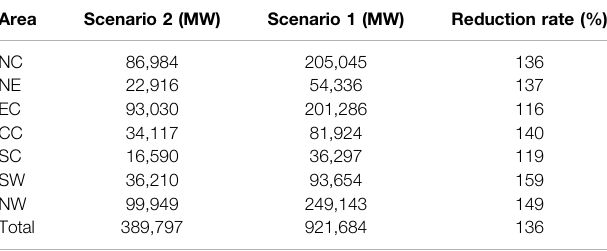
NC, NE, EC, CC, SC, SW, NW, respectively represents North China, Northeast China, East China, Central China, South China, Southwest China, Northwest China; The reduction rate is the ratio of the reduction to the demand in Scenario 2.